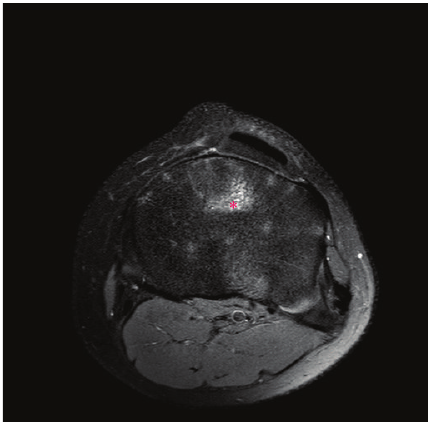
Figure 6: A 13-year-3-month-old female with FOPE zones at both proximal tibiae. Findings: axial proton density fat-saturated image at the level of the proximal tibia physis shows the periphyseal edema located at the anterocentral aspect of the central physis (asterisks). Technique: axial PD fat-saturated MRI (TR = 2,843.2, TE = 30), ST